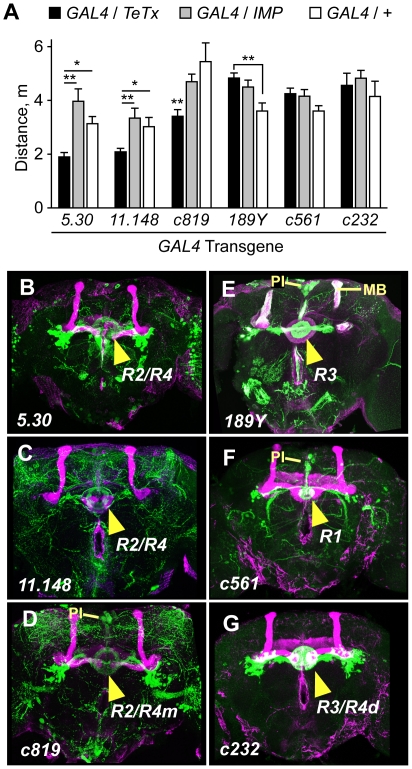
Functional mapping of ellipsoid body neurons in ethanol-induced hyperactivity.Blockade of evoked release in patterns that included R2/R4 neurons of the ellipsoid body (B–D, GAL4 transgenic lines 5.30, 11.148, and c819) resulted in reduced ethanol-induced hyperactivity (A). Ethanol-induced hyperactivity was not reduced by TeTx expression in patterns that included R1 (c561), R3 (189Y, c232), or R4d (c232) neurons of the ellipsoid body (E–G). *P<0.05, **P<0.01, 1-way ANOVA for a given GAL4 transgene, Tukey's multiple comparison test, n≥5. For c819/TeTx vs. c819/IMP, **P = 0.0041, 2 sample t-test, n = 8. B–G. Expression of UAS-GFP (green) by the indicated GAL4 transgene, counterstained with FasII antibodies (magenta). Arrowheads indicate innervation of the ellipsoid body ring. PI: pars intercerebralis, MB: mushroom bodies.